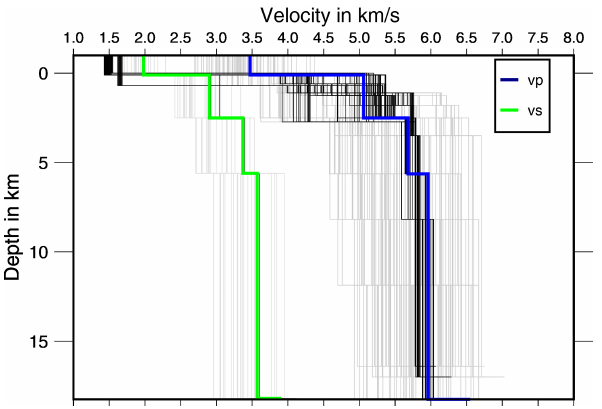
Figure 3. VELEST input models for v p (84) and v s (21) (gray) and output v p (84) and v s (21) after inversion (black) together with the chosen model ASZmod1 (colored). A good convergence of the models can be observed, especially for v s . The second layer con- verges worst. An instability of the first layer with a tendency to unrealistic low seismic velocities can be seen. For this reason, the velocity of ASZmod1 was fixed in the first